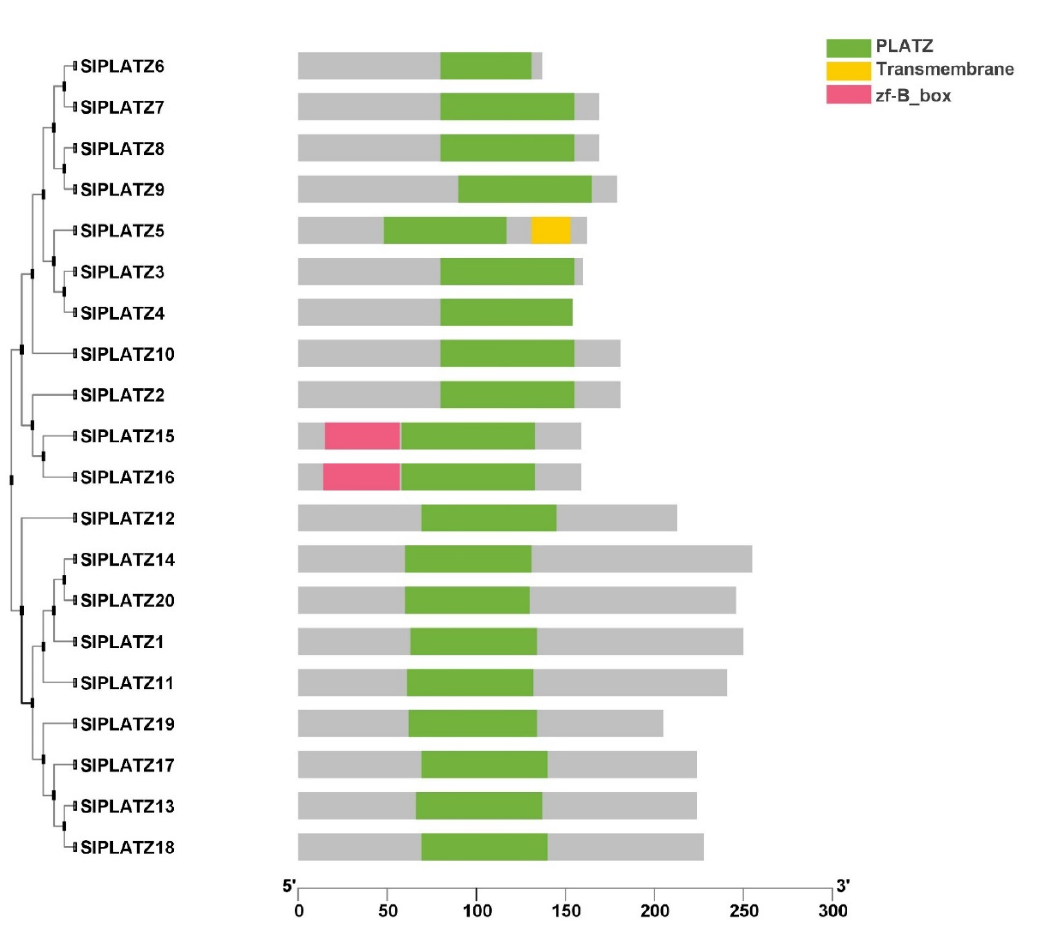
Figure 3. Schematic depiction of the conserved domains of the tomato PLATZ proteins. The trans- membrane domain (TM), the PLATZ domain, and the B-box-type (B_box) zinc finger domain iden- tified in SlPLATZ proteins are displayed in yellow, green, and red boxes, respectively.